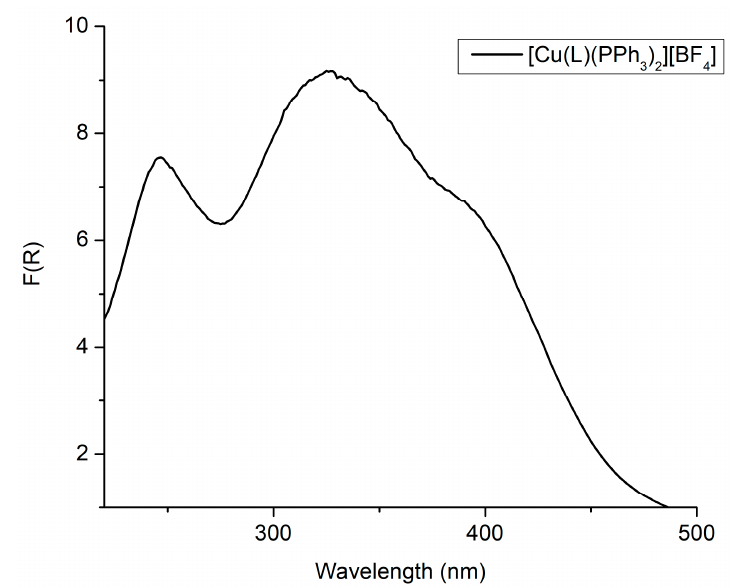
Figure 2. The Kubelka–Munk spectrum of the solid [CuL(PPh 3 ) 2 ]BF 4 .